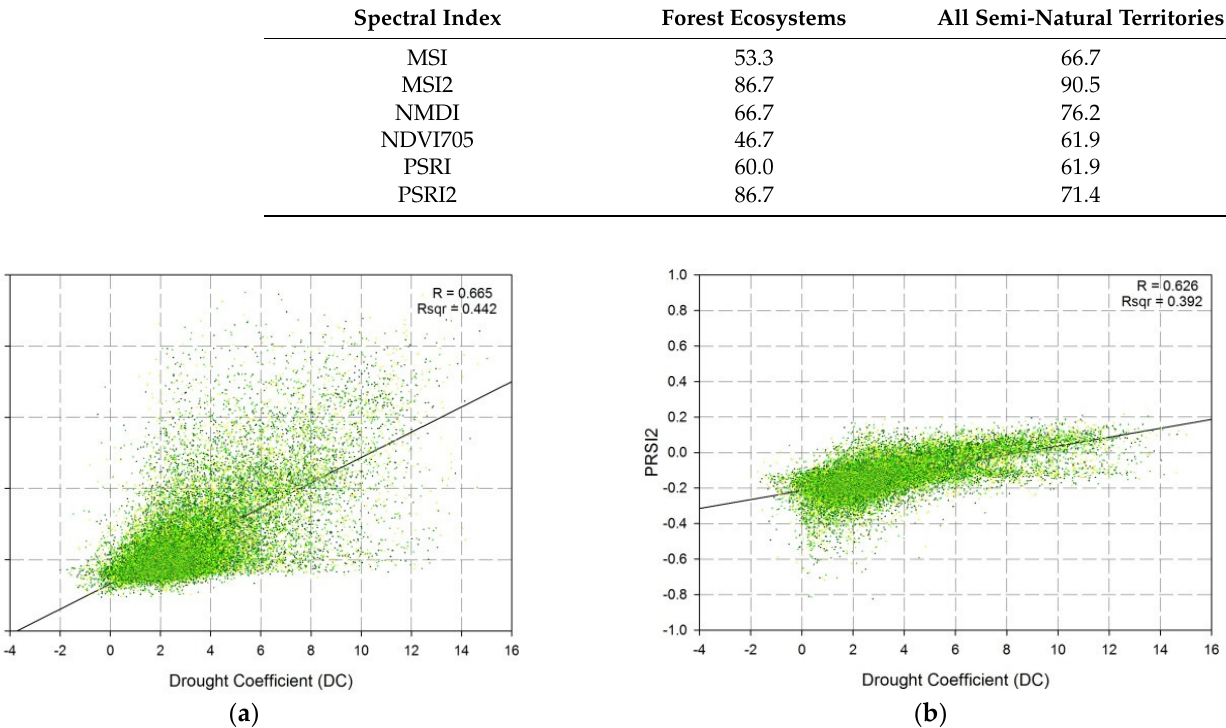
Figure 12. Linear regression analyses for the independent Drought coefficient (DC) and dependent ( a ) modified Moisture Stress Index (MSI2) and ( b ) modified Plant Senescence Reflectance Index (PSRI2).